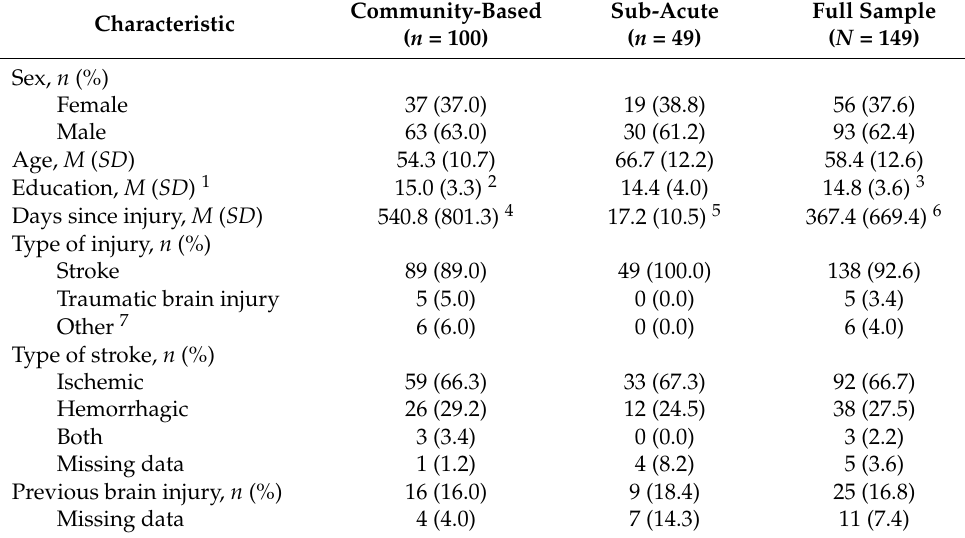
Table 1. Characteristics of participants.